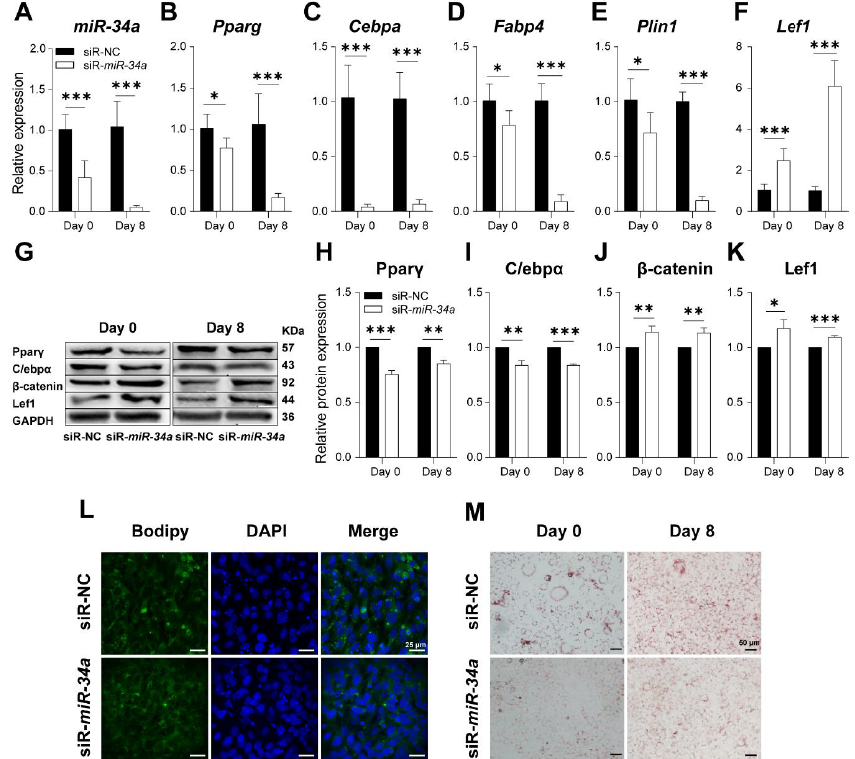
Figure 7. Silencing miR-34a suppresses adipogenesis. miR-34a inhibitor (siRNA) could efficiently decrease the expression of miR-34a in 3T3-L1 ( n = 6) ( A ). The expression of Pparg ( B ), Cebpa ( C ), Fabp4 ( D ), Plin1 ( E ), and LEF1 ( F ) on day 0 and day 8 during 3T3-L1-derived preadipocyte differentiation after miR-34a silencing ( n = 6 ). The protein expression level of Pparγ ( G ), C/ebpα ( H ), β -catenin ( I ), and Lef1 ( J ) in NC and miR-34a inhibitor groups along with differentiation via Western blot ( n = 3) ( K ). Lipid droplet accumulation in 3T3-L1 cells on day 0 and 8 of differentiation detected using BODIPY staining ( L ) and Oil Red O staining ( M ) in NC and miR-34a inhibitor groups. * p < 0.05, ** p < 0.01, *** p < 0.001 versus NC.